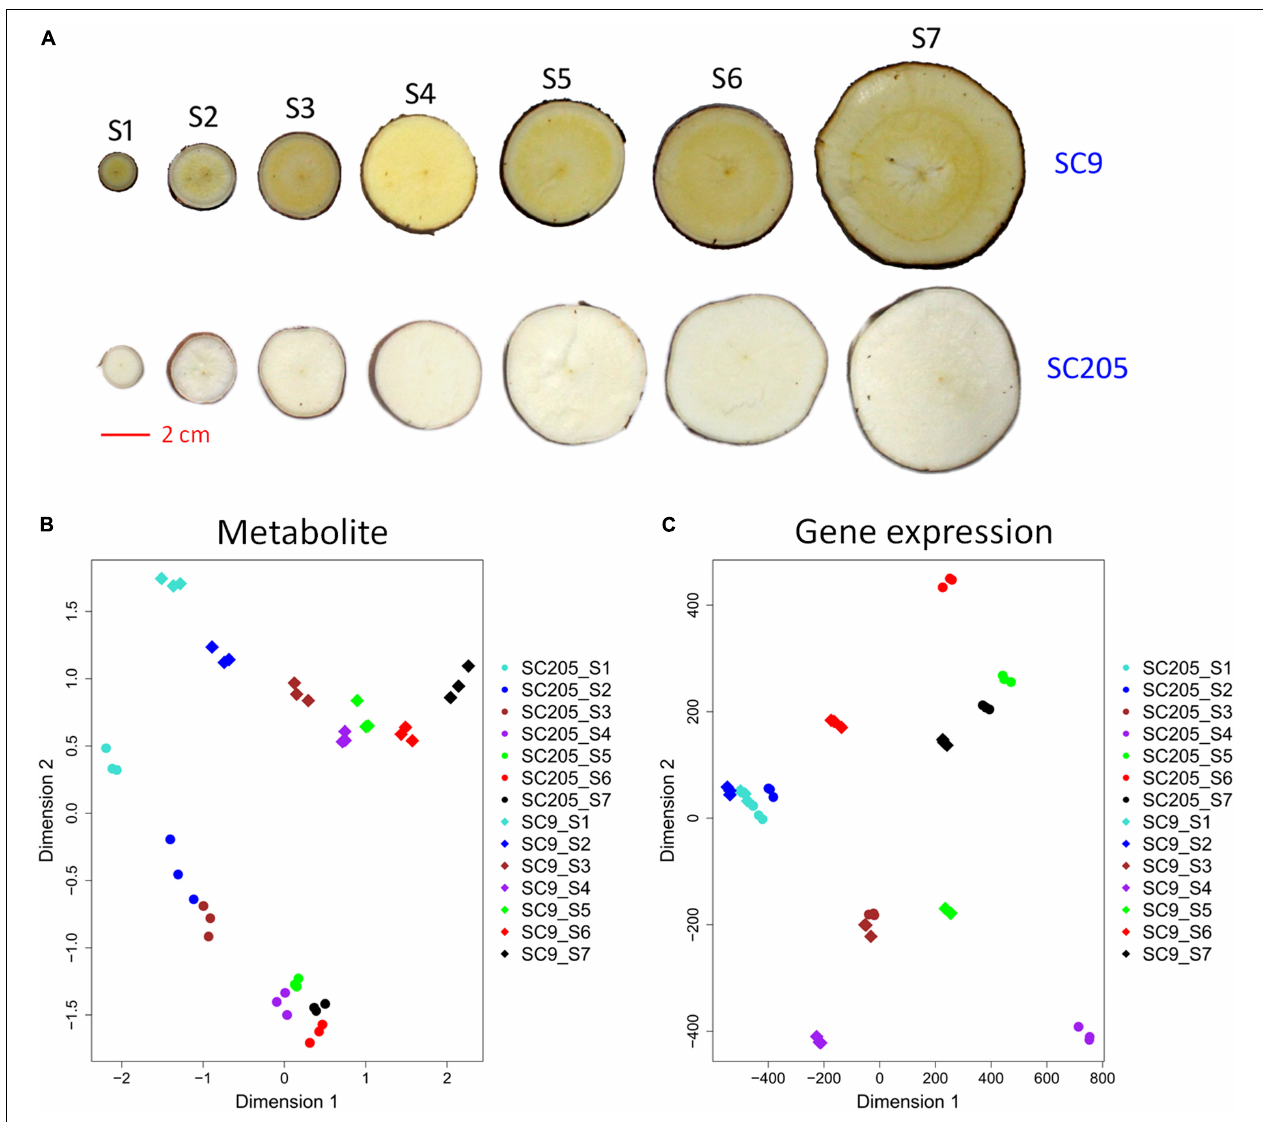
FIGURE 1 | Overview of tuberous roots of SC9 and SC205. (A) Phenotypes of SC9 and SC205 tuberous roots collected at seven developmental stages from 100–340 days after planting: S1, 100; S2, 140; S3, 180; S4, 220; S5, 260; S6, 300; and S7, 340. The scale bar equals 2 cm. (B,C) Clustering of tuberous root samples based on the metabolite levels and gene expression profiles, respectively. The symbols with the same color represent different replicates of a